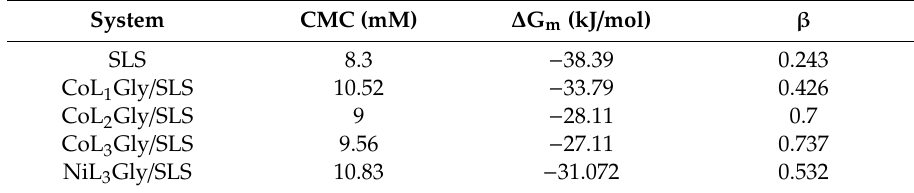
Table 5. Calculated micellar parameter for the interaction of complexes with